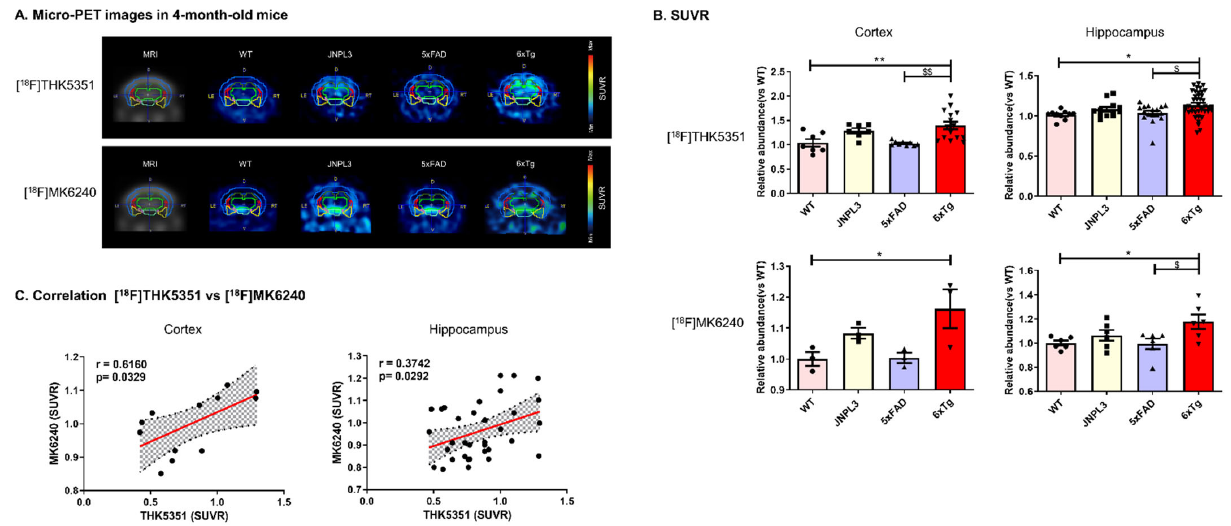
increase in whole ‐ brain uptake in 6 × Tg mice (Figures 4A and S6A).